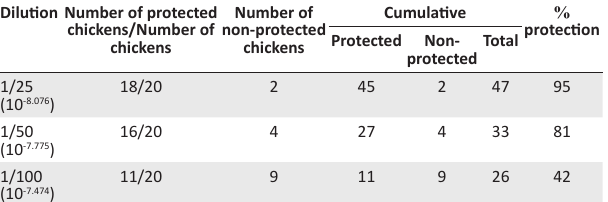
TABLE 5: Potency test of binary ethylenimine-inactivated Newcastle disease virus vaccine formulated in black seed oil as adjuvant. Dilution Number of protected chickens/Number of